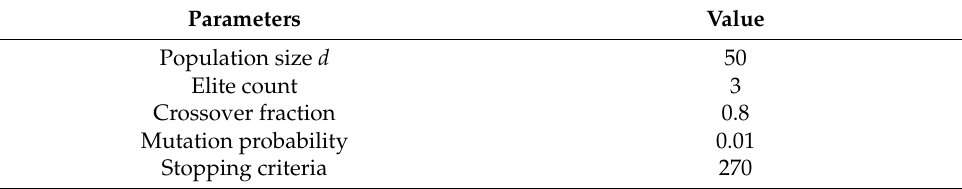
Table 8. Parameter settings of the genetic